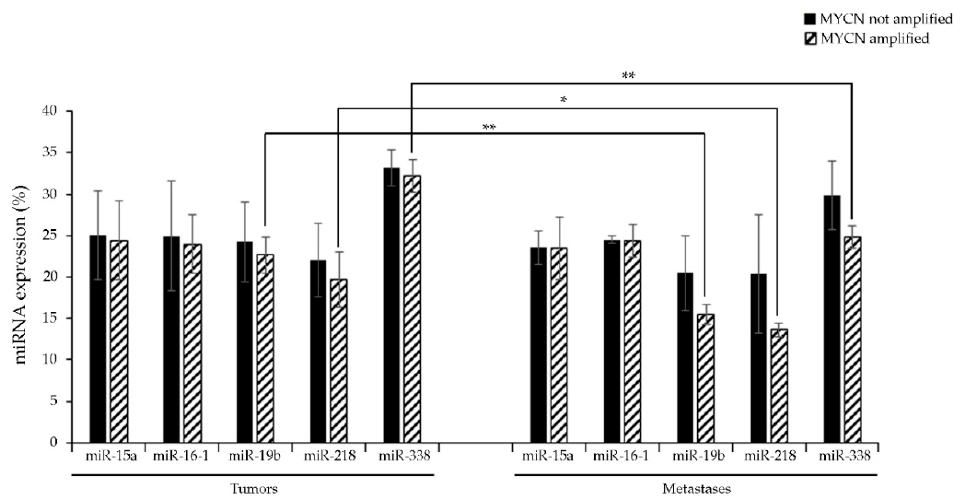
Figure 4. RT-qPCR analysis of the selected miRNA expression levels in tumors and metastases samples of NB patients. Data is reported as % variation vs. the universal small nuclear RNU38B. * p < 0.05 vs. MYCN -amplified tumors; ** p < 0.01 vs. MYCN -amplified tumors.